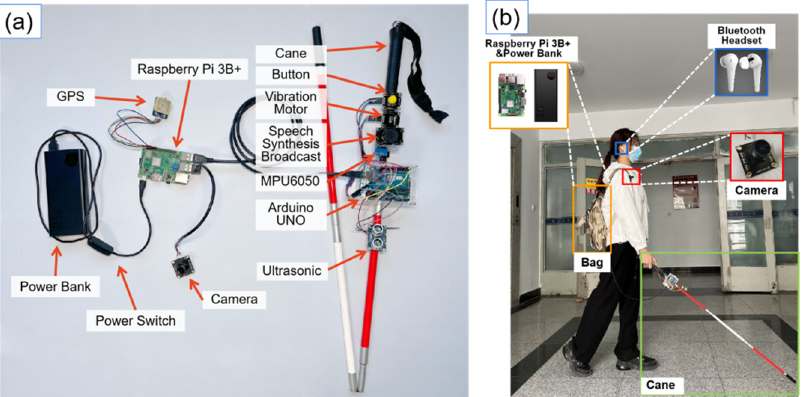
Figure 3. Instructions for the use of the assistance tool for VIPs. ( a ) Detailed drawings of assistive devices for VIPs. ( b ) Schematic diagram of a person wearing the device.